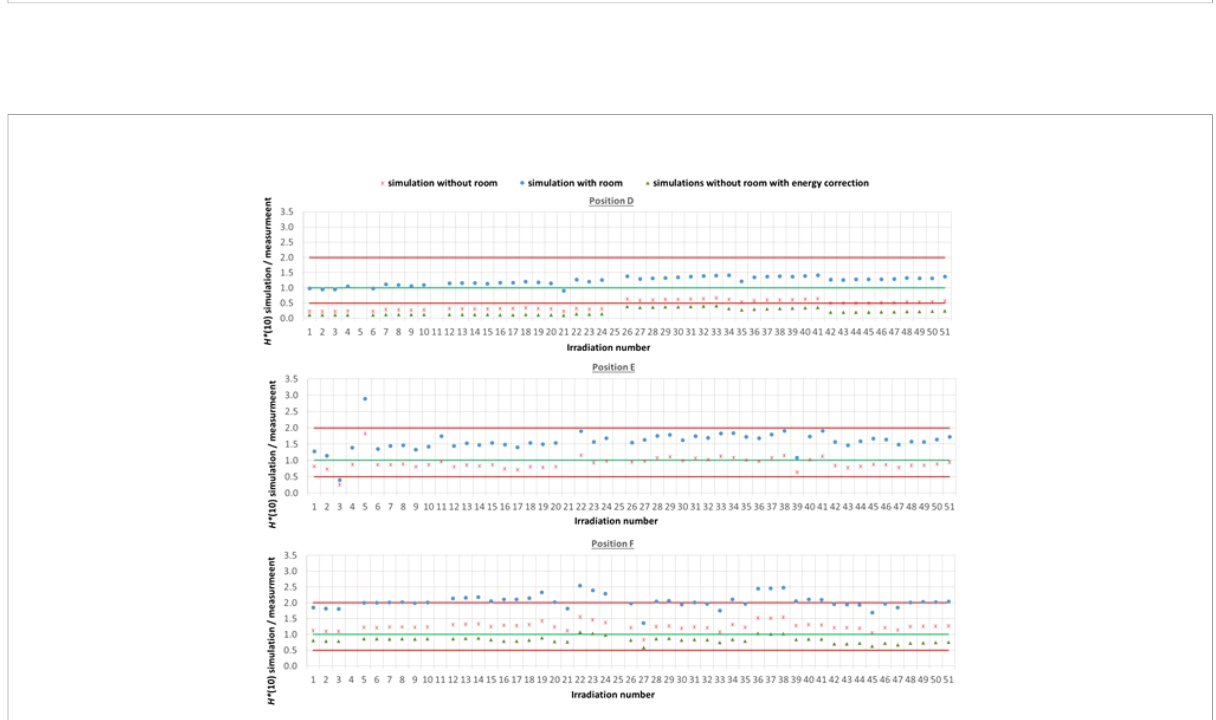
FIGURE 6 Plots with the ratio of simulated over measured H*(10) for positions (D – F) for the Skandion measurement campaign. Three cases are shown: simulations without room (red crosses), simulations with room (blue circles), and simulations without room and correction for the imperfect ambient neutron monitor H*(10) energy response (green triangles). A green line indicating a ratio of one and two red lines indicating a factor of two over- or under-response are added to guide the